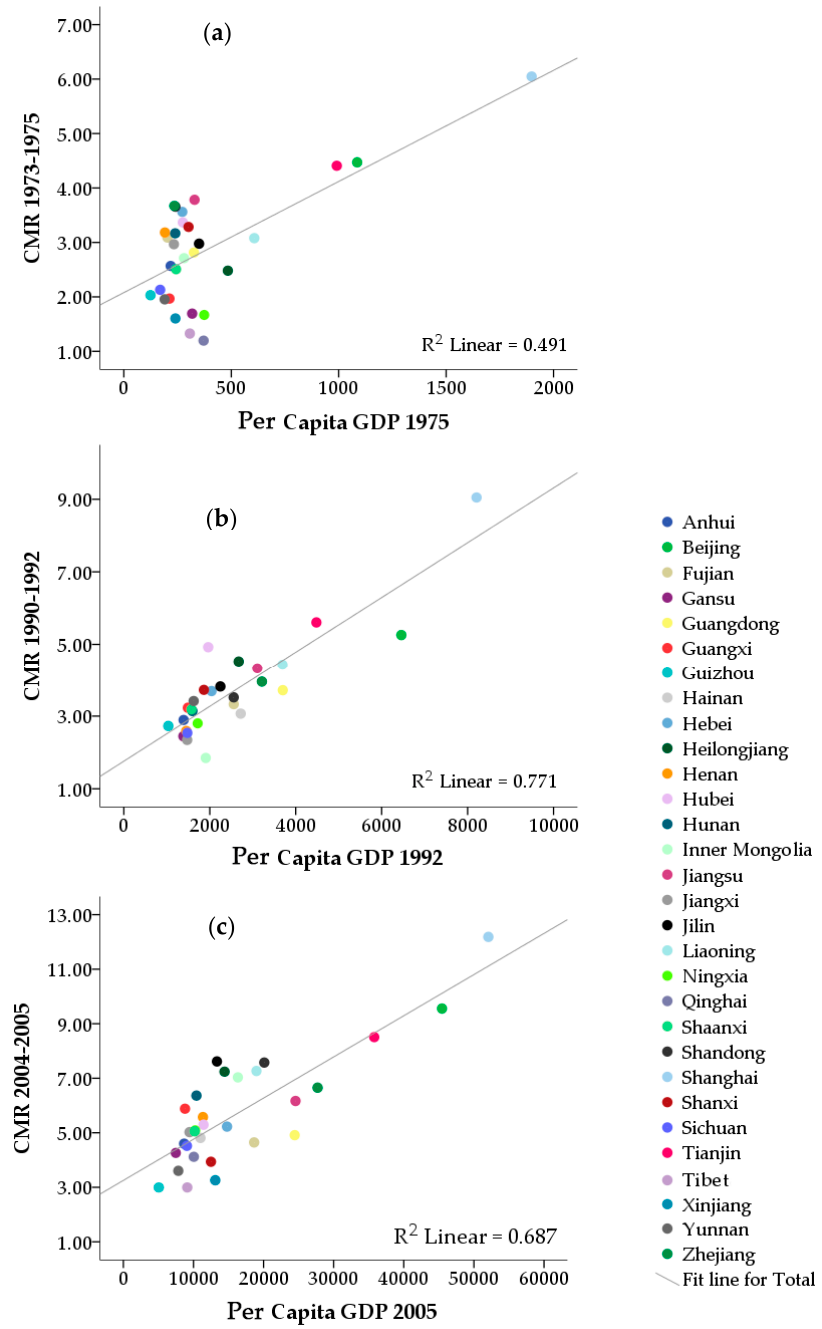
Figure 4. Scatterplot for the crude mortality rate (CMR) of breast cancer and per capita GDP by province. The linear relation between breast cancer CMR over the period: ( a ) 1973–1975 and per capita GDP for 1975 across 30 provinces; ( b ) 1990–1992 and per capita GDP for 1992 across 27 provinces; ( c ) 2004–2005 and per capita GDP for 2005 across 30 provinces.